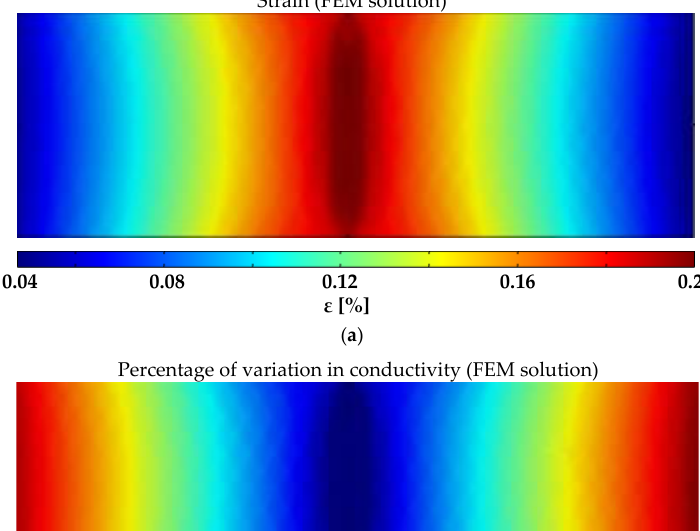
( d ) Figure 16. ERT object localization tests: ( a – c ) single coin in different positions; ( d ) two coins on the surface. Figure 17. ERT damage identification test. Finally, the system was used to monitor the state of deformation of the rectangular FR4 plate described in Section 2.7 subjected to a 3-point bending test ((Figure 8b) with a span of 160 mm and reaching a maximum flexural strain of 0.2%. COMSOL Multiphysics software was also used for finite element method (FEM) analyses and for predicting the electromechanical response. The dimensions of the substrate, of the coating and of the electrodes, as well as the effective conductivity at rest of the GNP-based paint and its pi- ezoresistive coefficients vs. strain derived from the GF curve in Figure 12, were all inputs